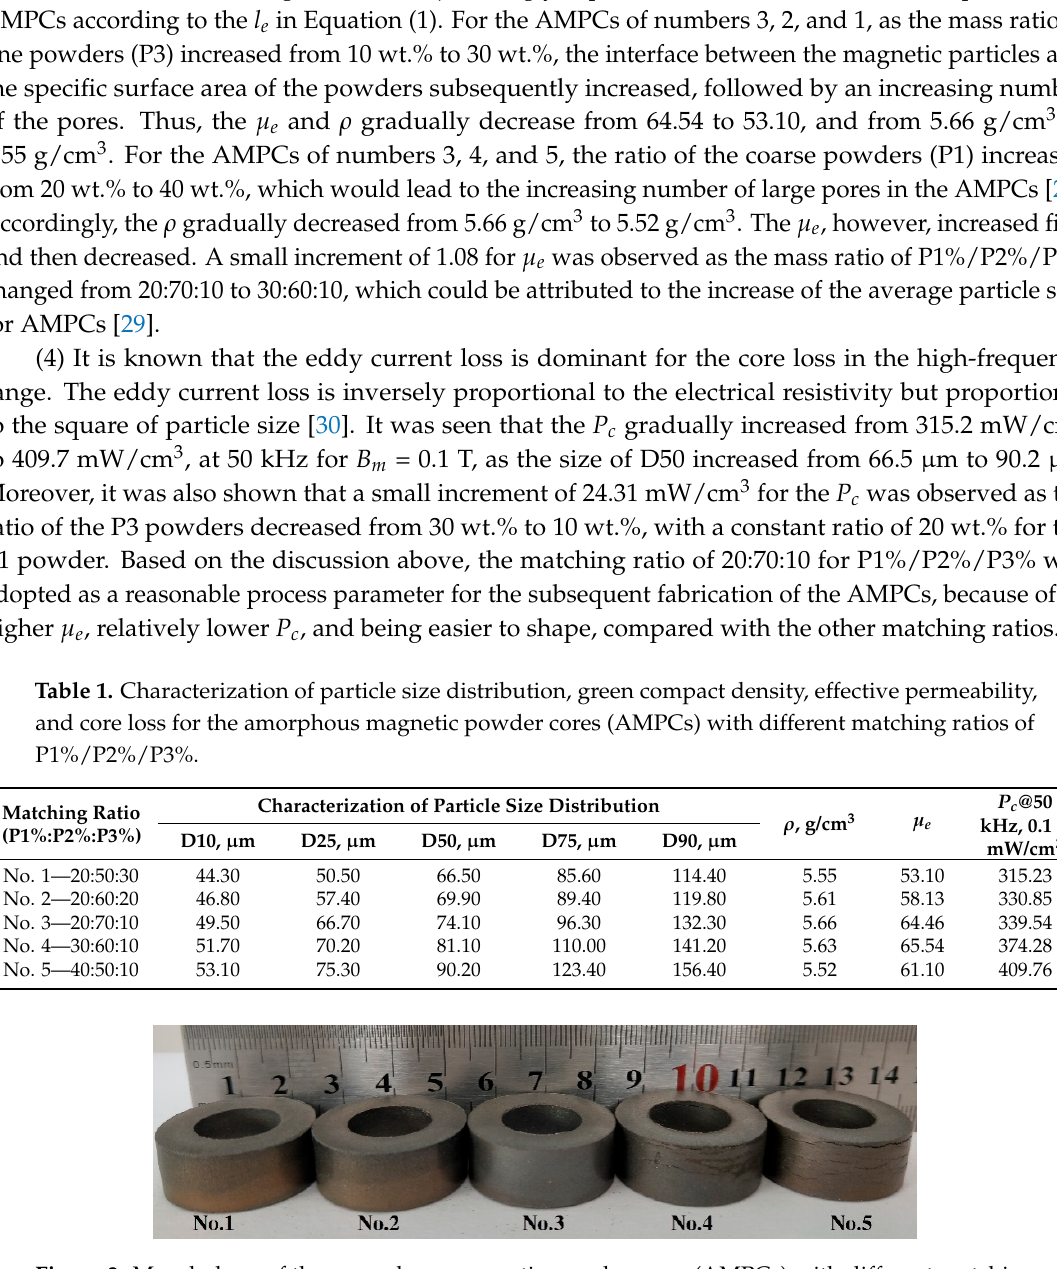
Figure 2. Morphology of the amorphous magnetic powder cores (AMPCs) with different matching ratios of P1%/P2%/P3%.